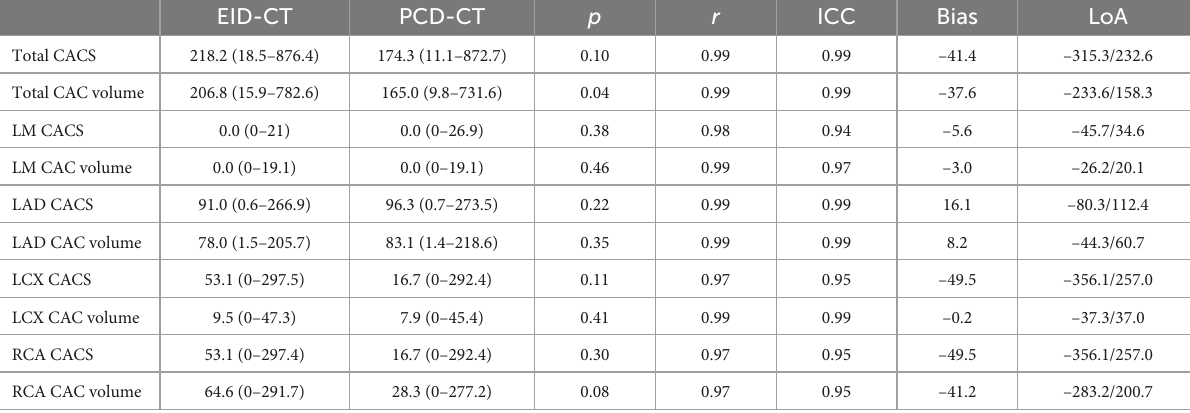
TABLE 3 Comparison of total and per-vessel values between EID-CT and PCD-CT in